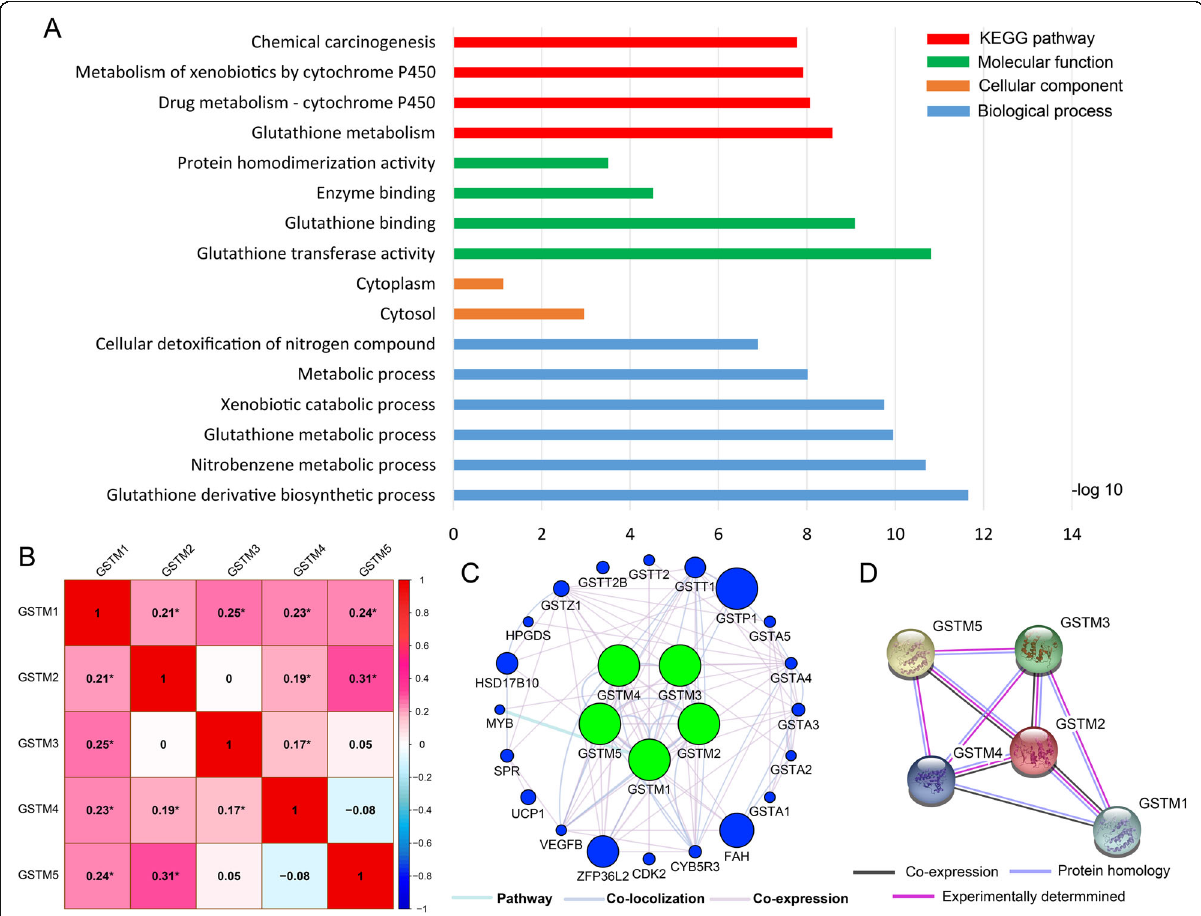
Fig. 2 ( a ) GO enrichment and KEGG pathway analysis by DAVID; ( b ) Pearson ’ s correlation coefficients between GSTM gene expression levels. * P < 0.001; ( c ) Gene-gene interaction network for GSTM gene family by GeneMANIA. ( d ) Protein-protein interaction network for GSTM gene